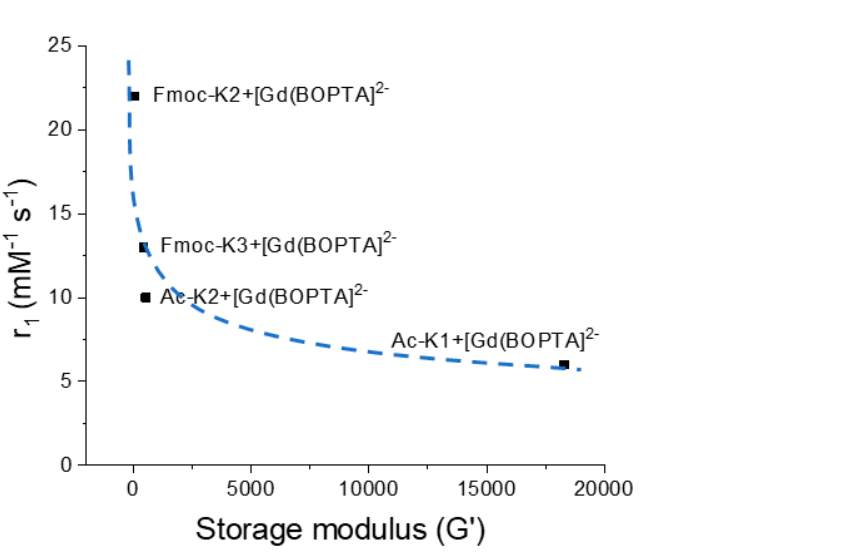
Figure 5. Dependence of r 1 values (20 MHz and 298K) on the storage modulus (G ′ ) of hydrogels based on [Gd(BOPTA)] 2 − .